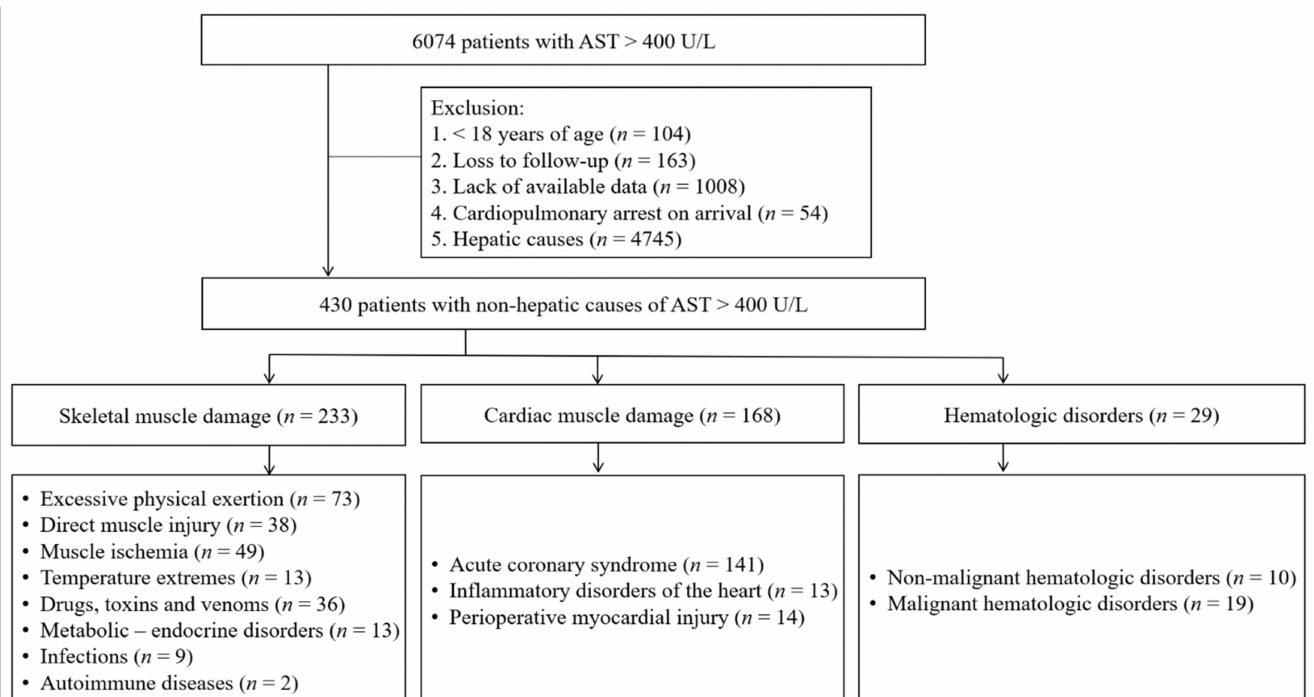
Figure 1. Flowchart of patients divided into three etiologic